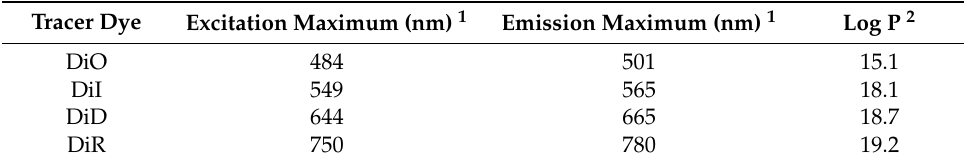
Table A1. Excitation and emission maxima and predicted LogP for dyes encapsulated in NCs for this study.